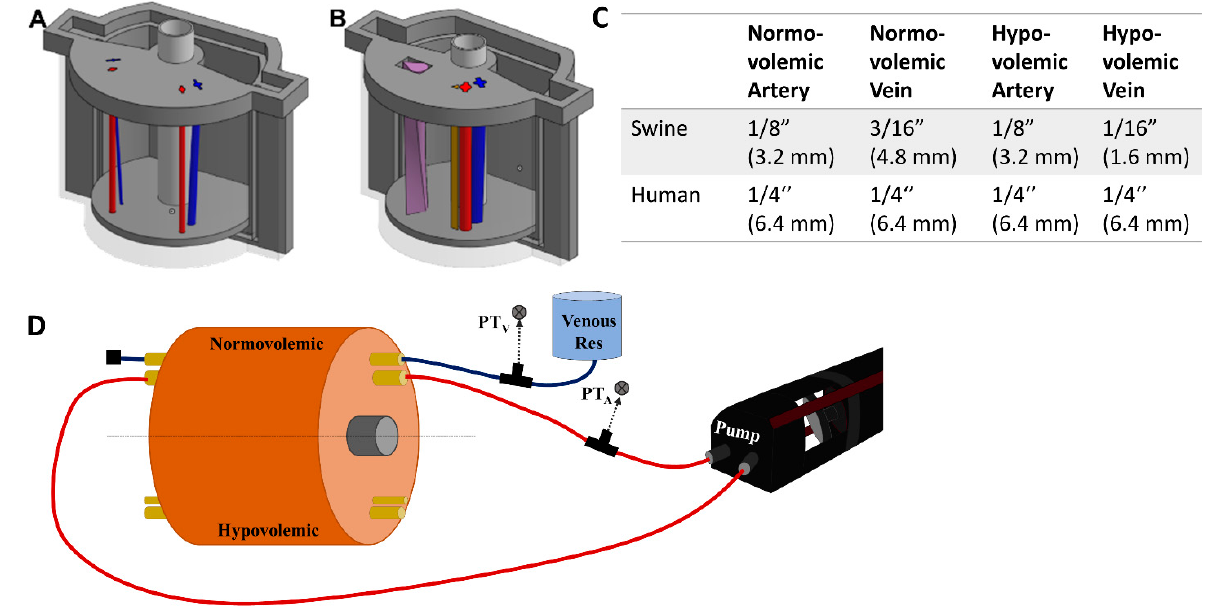
Figure 1. Overview of the phantom design and flow loop setup. ( A ) CAD assembly of the porcine tissue phantom model with arterial (red) and veinous (blue) channel inserts. Left side of the model was for hypovolemic conditions while the right side was normal. ( B ) CAD assembly of the human tissue phantom model with addition of nerve fiber bundle. Left side of the model shows the neurovascular bundle (purple teardrop channel) while the right shows the three individual channels for artery (red), vein (blue) and nerve fiber (brown). ( C ) Summary of the tubing sizes used for normal and hypovolemic conditions for swine and human models. Outer diameters are shown in inches with mm sizes shown in parentheses. ( D ) Flow loop setup for the arterial (red) and venous (blue) channels of the phantom model. Only the normovolemic side is plumbed in the diagram but the same setup would apply for the hypovolemic scenario. Note this setup is not to scale and the phantom model is shown as a large component to the rest of the hardware to highlight features within the phantom.